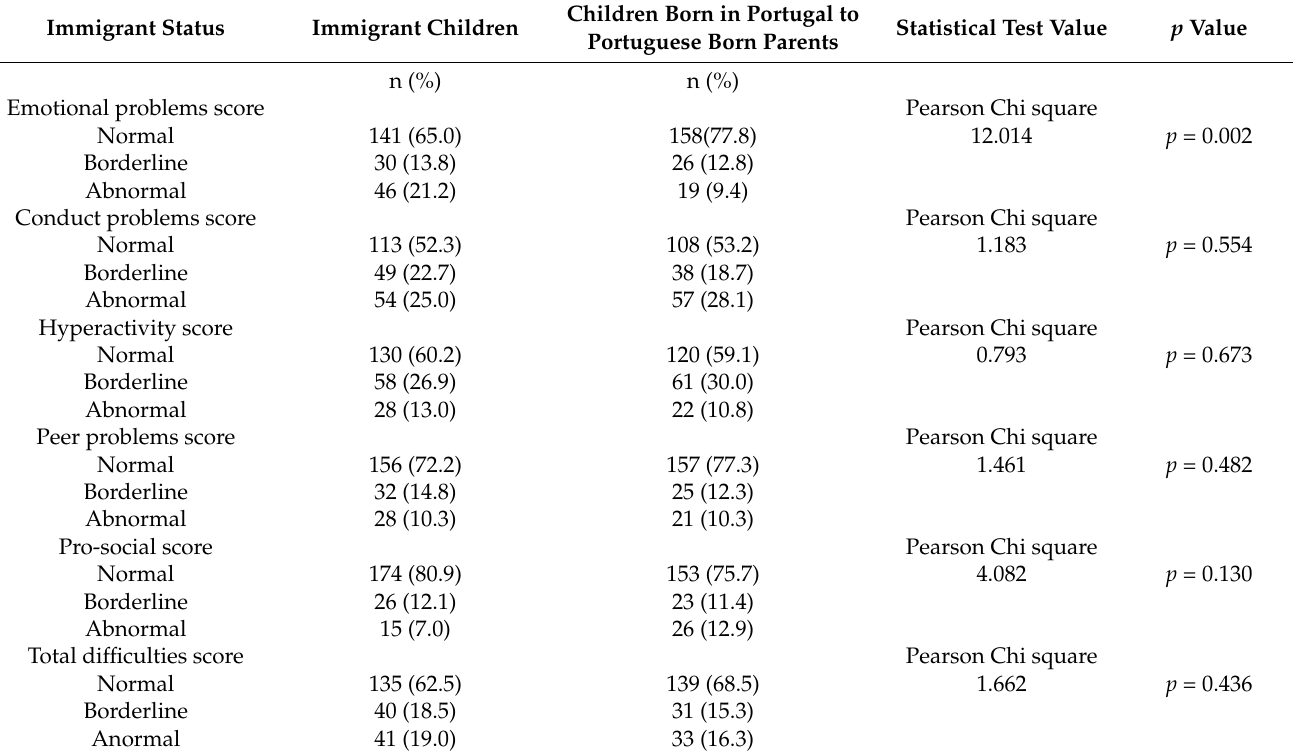
Table 5. Strengths and Difficulties Questionnaire (SDQ) Scores: comparing first generation immigrant children with children born in